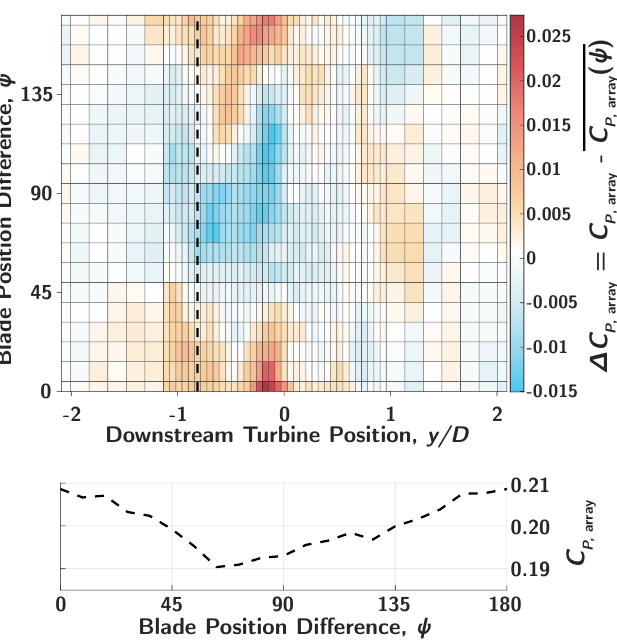
Fig. 7. Top: Gain or loss in performance possible using coordinated control as a function of turbine relative position and blade position difference. Gain or loss is relative to mean performance across all blade position differences (the purple line in Fig. 6. The dashed line indicates the relative turbine position at which peak array performance occurs. Bottom: Array performance as a function of blade position difference at the relative turbine position of peak